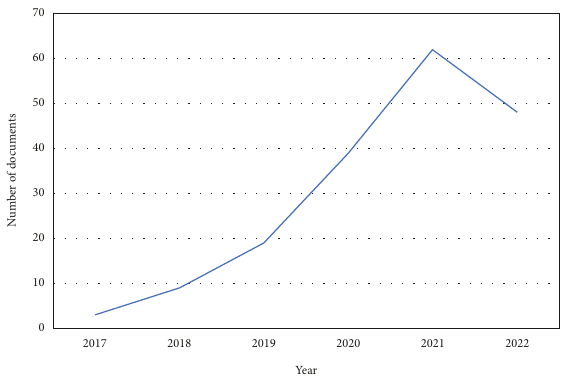
Figure 3: Scienmetric review procedure